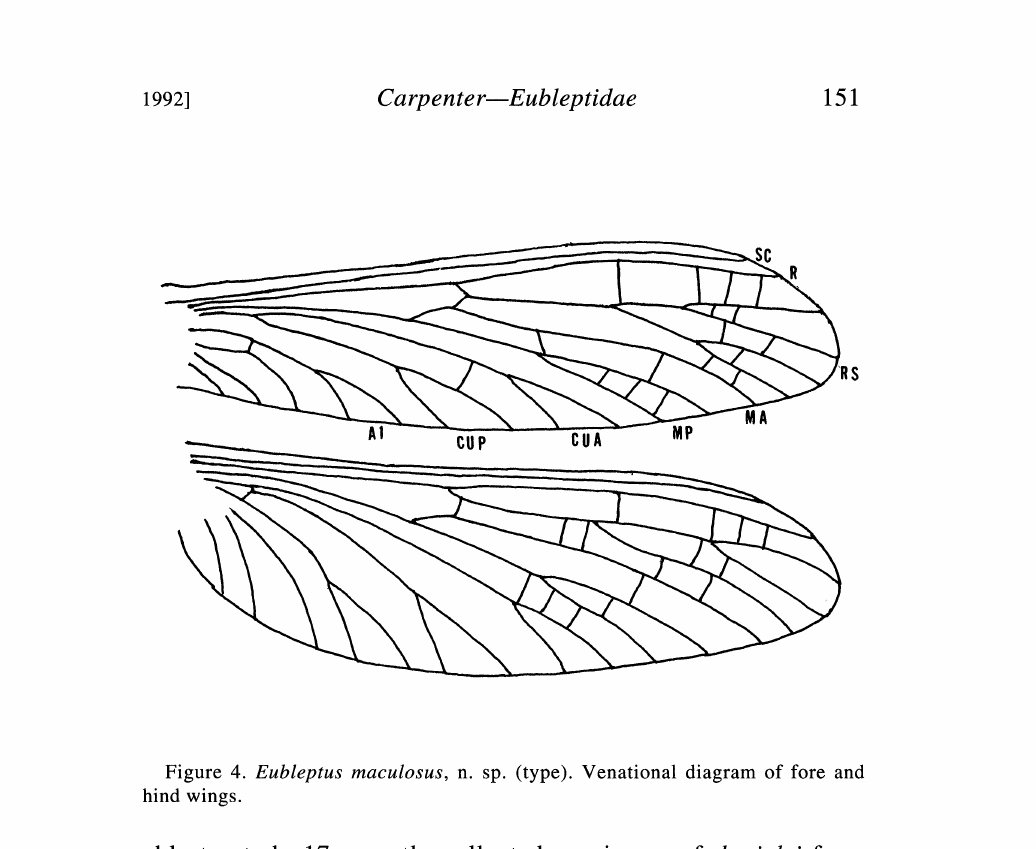
Figure 4. Eubleptus maculosus, n. sp. (type). Venational diagram of fore and hind